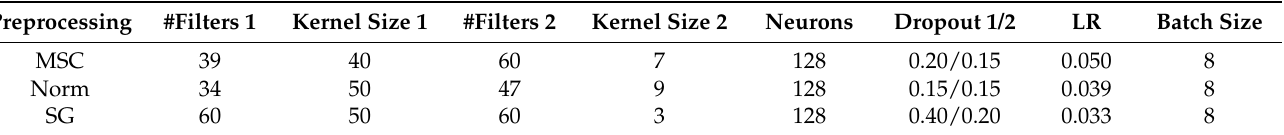
Table 3. Optimized hyperparameters of 1D CNN for each preprocessing method using BOGP.